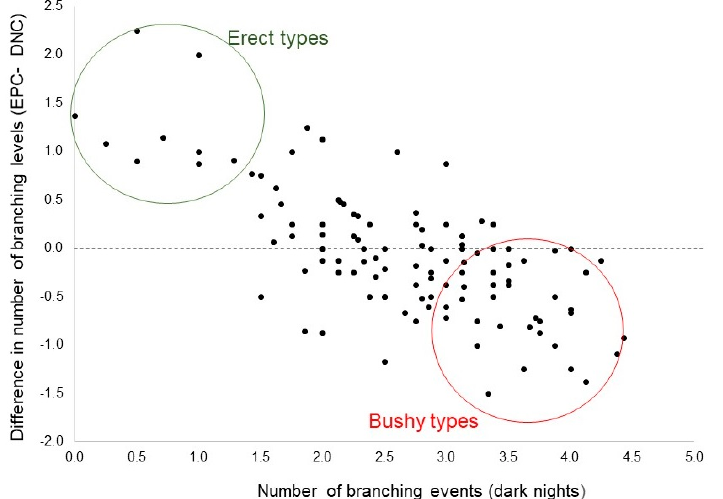
Figure 8. Extent to which extended photoperiod hastened flowering (difference between average number of branching events per plant under EP and DN as a function of average number of branching events per plant under DN in 116 elite cassava genotypes).